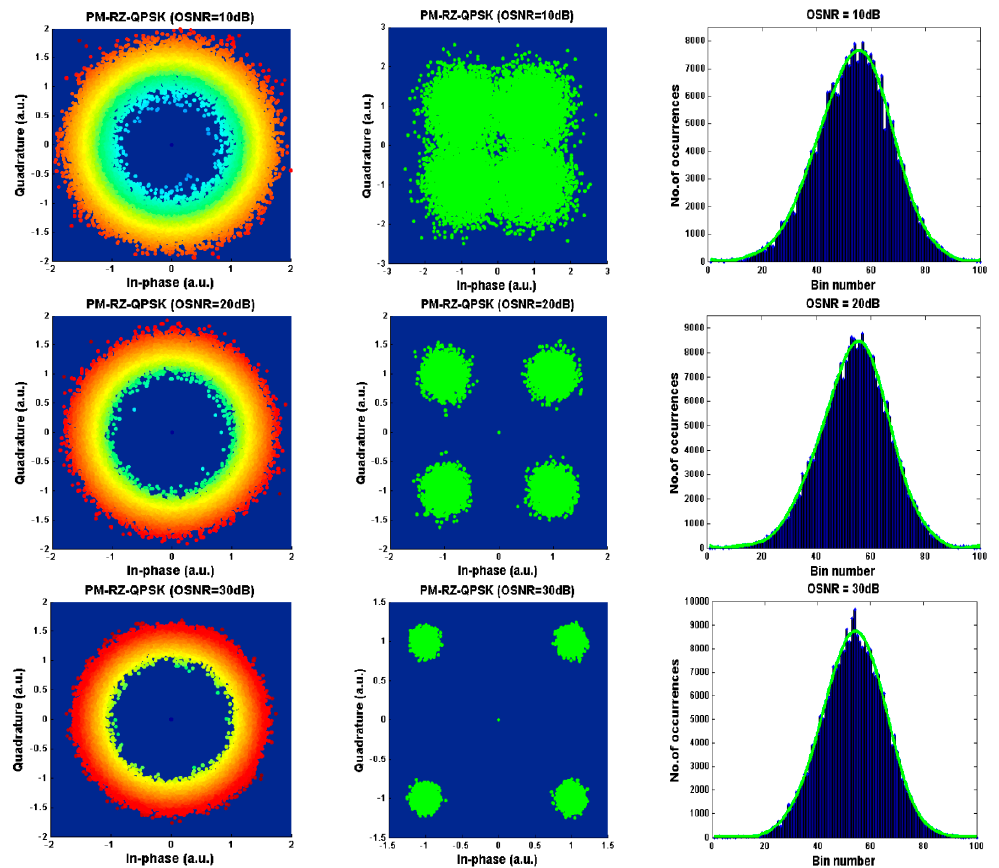
Figure 2. Constellation diagrams and amplitude histograms with Fourier fitting at three different OSNRs for PM-RZ-QPSK signals.